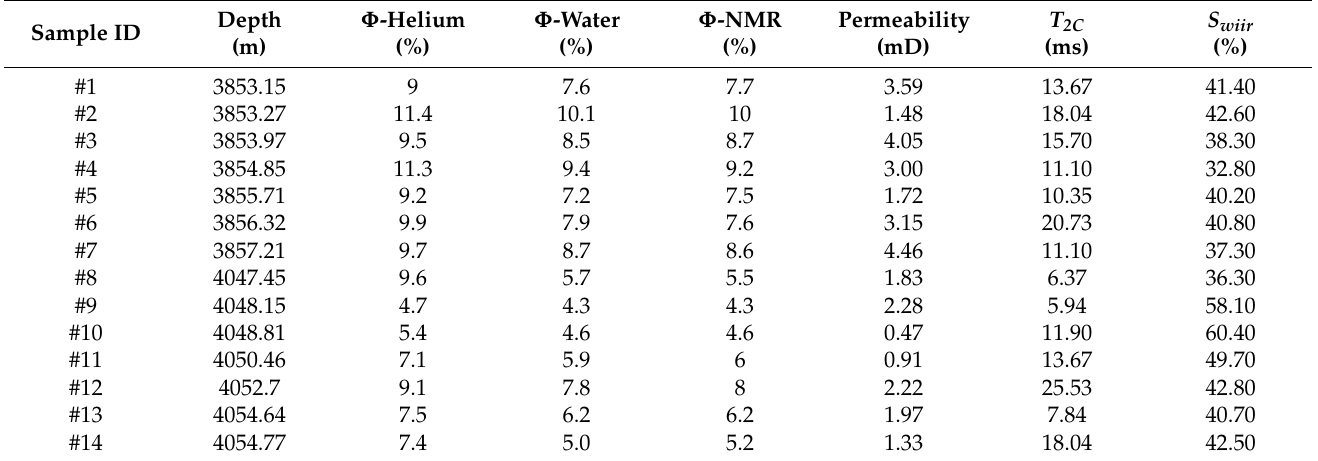
Table 1. Petrophysical properties of selected coarse clastic rock samples.